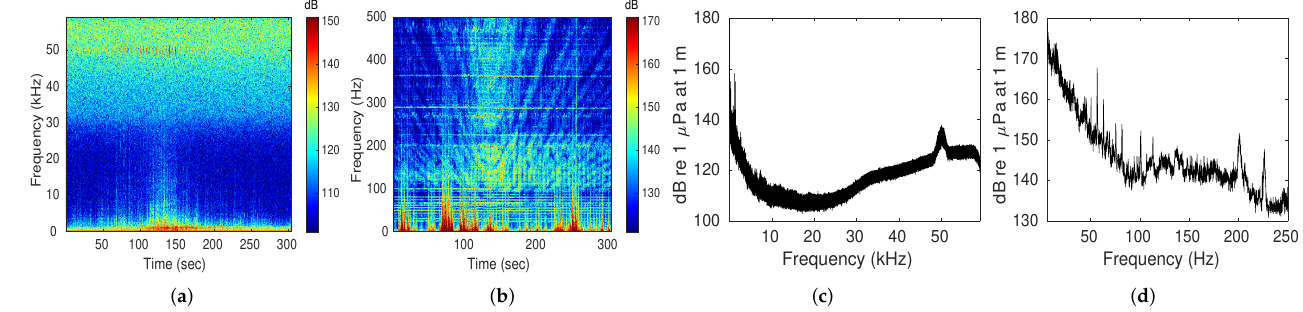
Figure 2. The power spectrum of ship-radiated underwater sound at 65% propeller pitch ratio. The spectrograms of acoustic signals ( a ) up to 60 kHz and ( b ) below 500 Hz, obtained by short-time Fourier transform. The power spectral density (PSD) distributions of a signal ( c ) up to 60 kHz and ( d ) below 250 Hz. Window = 16 s; overlap = 8 s; fft points = 2 21 ; ∆ f = 0.0625 Hz.